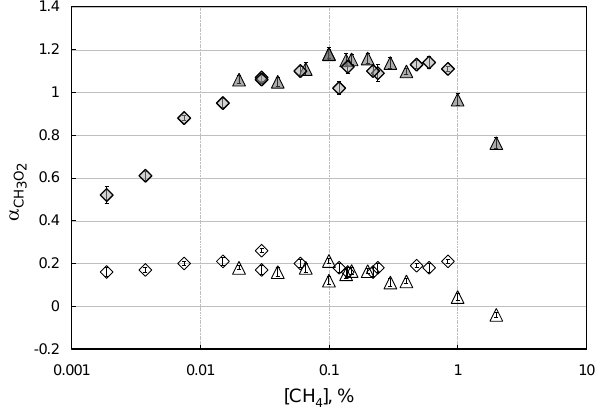
Fig. 7. Dependence of α CH on CH 4 mixing ratio in the calibra- 3 O 2 tion cell. Closed and open symbols are the measured α CH values 3 O 2 at the HO 2 +RO 2 mode and HO 2 mode, respectively, and triangles and diamonds are the results from the single-dilution and double- dilution measurements, respectively. Error bars show the standard errors of each α CH 3 O 2